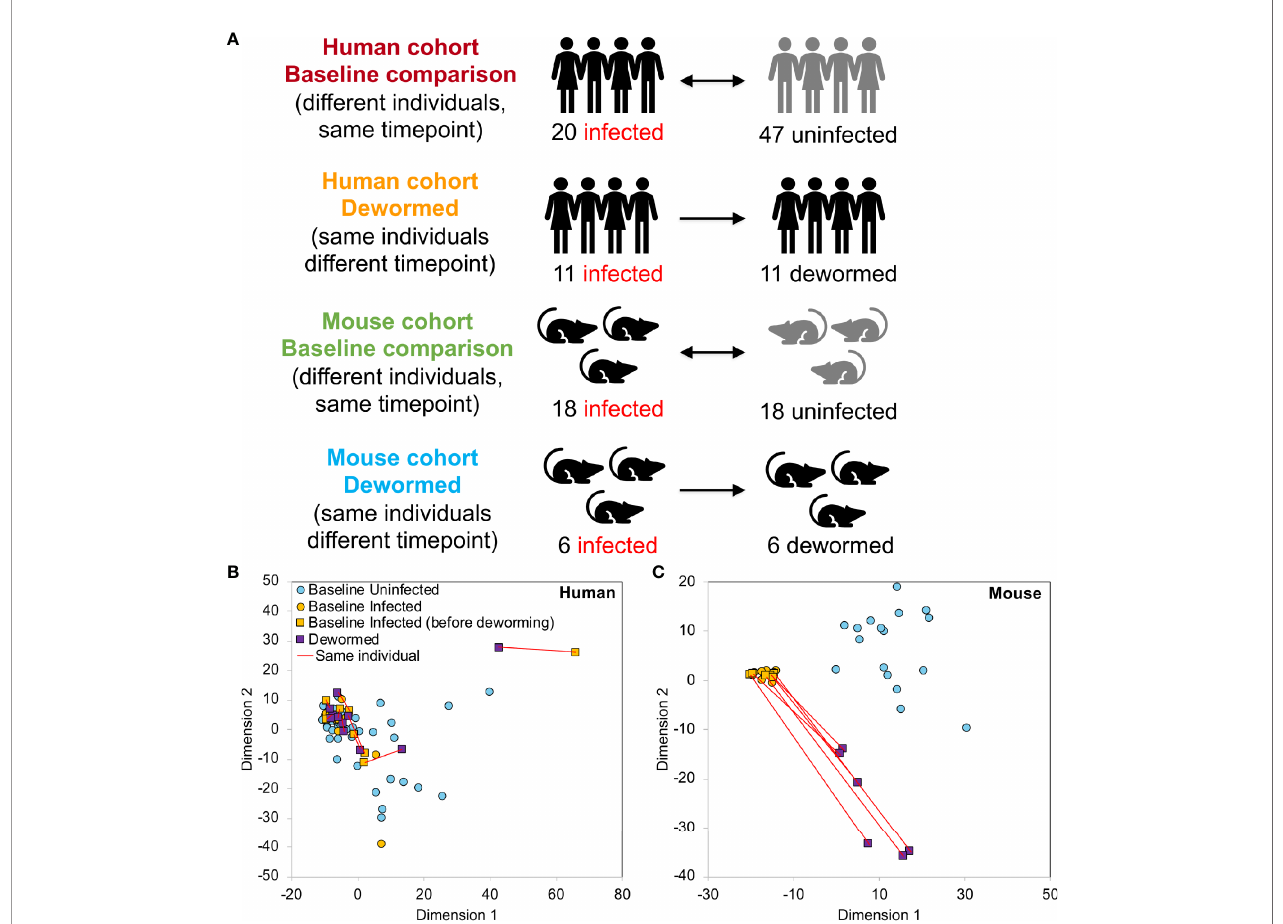
FIGURE 1 | Overview of 16S rRNA gene sample sets. (A) Sample cohorts used for differential intestinal microbiome analysis comparing samples from Trichuris trichiura -infected and uninfected humans and T. muris -infected and uninfected mice before and after deworming. At “ baseline ” , the microbiomes of different individuals were compared and in the “ dewormed ” comparisons, the microbiomes of same individuals before and after curing of the infection were compared. MDS- based clustering of samples based on their normalized microbiome abundance pro fi les are shown for human (B) and mouse (C) . Red lines connect samples from the same individuals before and after deworming. Normalization was performed by dividing OTU read counts by the total number of read counts assigned to OTUs in each